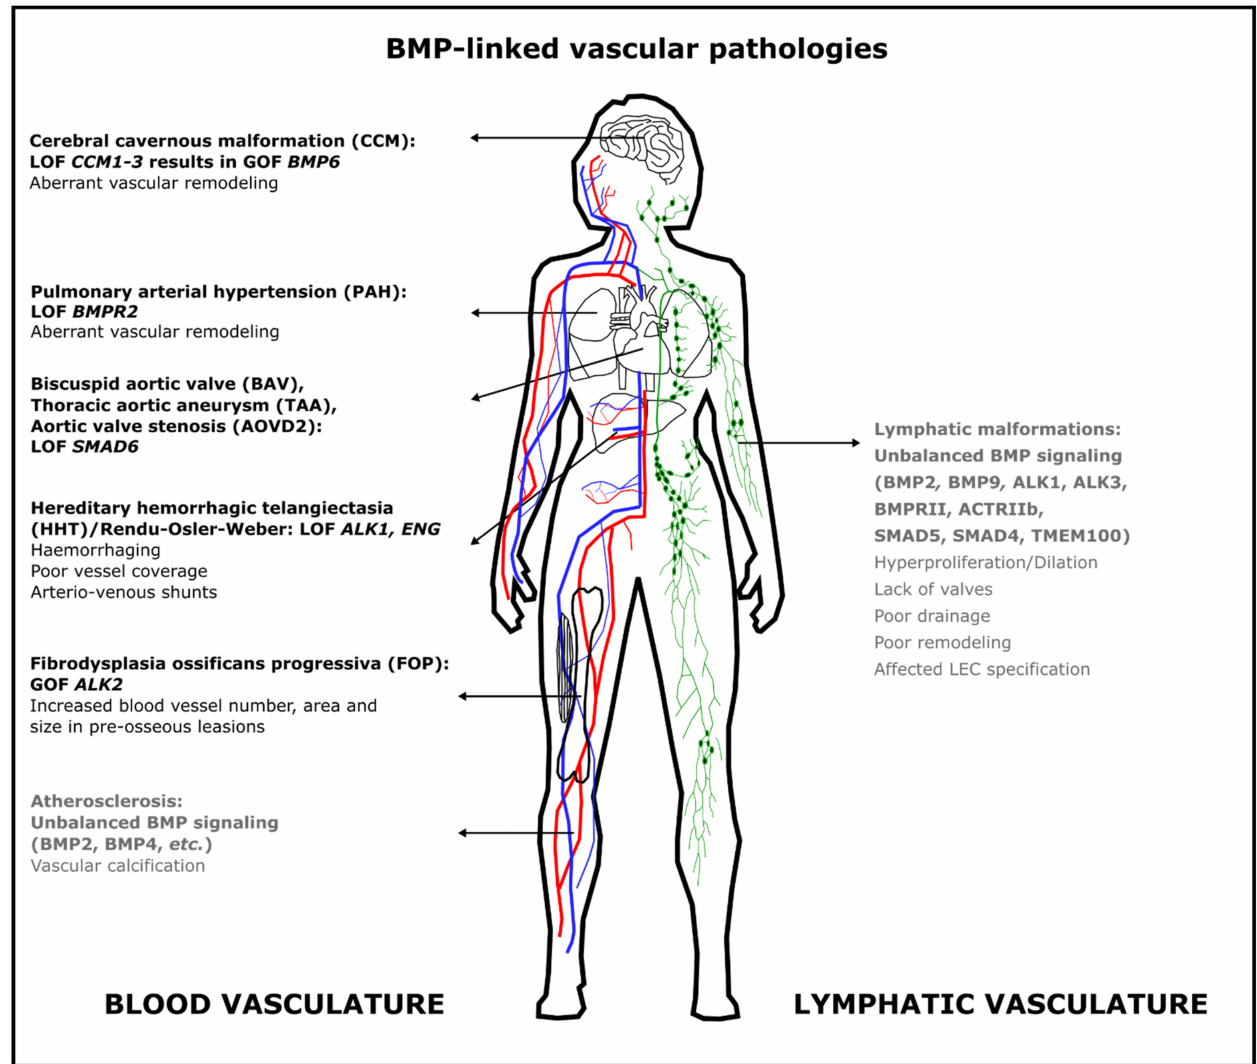
Figure 3. Aberrant BMP signaling in the blood vasculature causes different severe but rare diseases in humans. Some pathologies are due to loss of function of BMP signaling, whereas others result from gain of function of BMP signaling. The most frequent mutations are indicated here; additional mutations are discussed in the text. Text in gray indicates that this role for BMP signaling has only been demonstrated in animal models. Abbreviations: ACTRII: activin type II receptor; ALK: activin receptor-like kinase; AOVD2: aortic valve stenosis; BAV: bicuspid aortic valve; BMP: bone morphogenetic protein; BMPR2: BMP Type 2 receptor; CCM: cerebral cavernous malformation; ENG: endoglin; FOP: fibrodysplasia ossificans progressiva; HHT: hereditary hemorrhagic telangiectasia; GOF: gain of function; LEC: lymphatic endothelial cell; LOF: loss of function; PAH: pulmonary arterial hypertension; TAA: thoracic aortic aneurysm; TMEM100: transmembrane protein